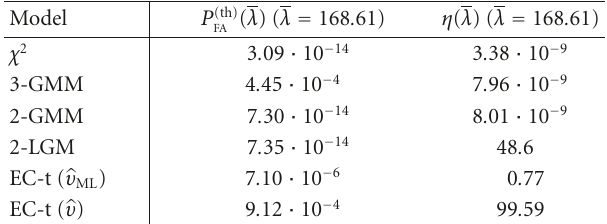
Table 5: Second column: values of the P FA predicted by using each theoretical model when the RX detector is applied to class no.1 data and detection is accomplished with a test threshold λ = 168 . 61. Third column: percentage of the P FA obtained by applying the RX detector to class no.1 data addressed by each theoretical model.